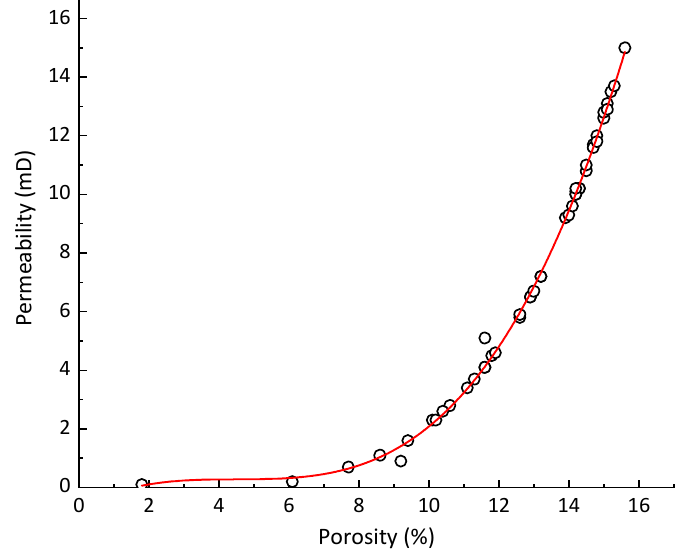
Figure 4. Permeability changes with porosity near well X-3 .